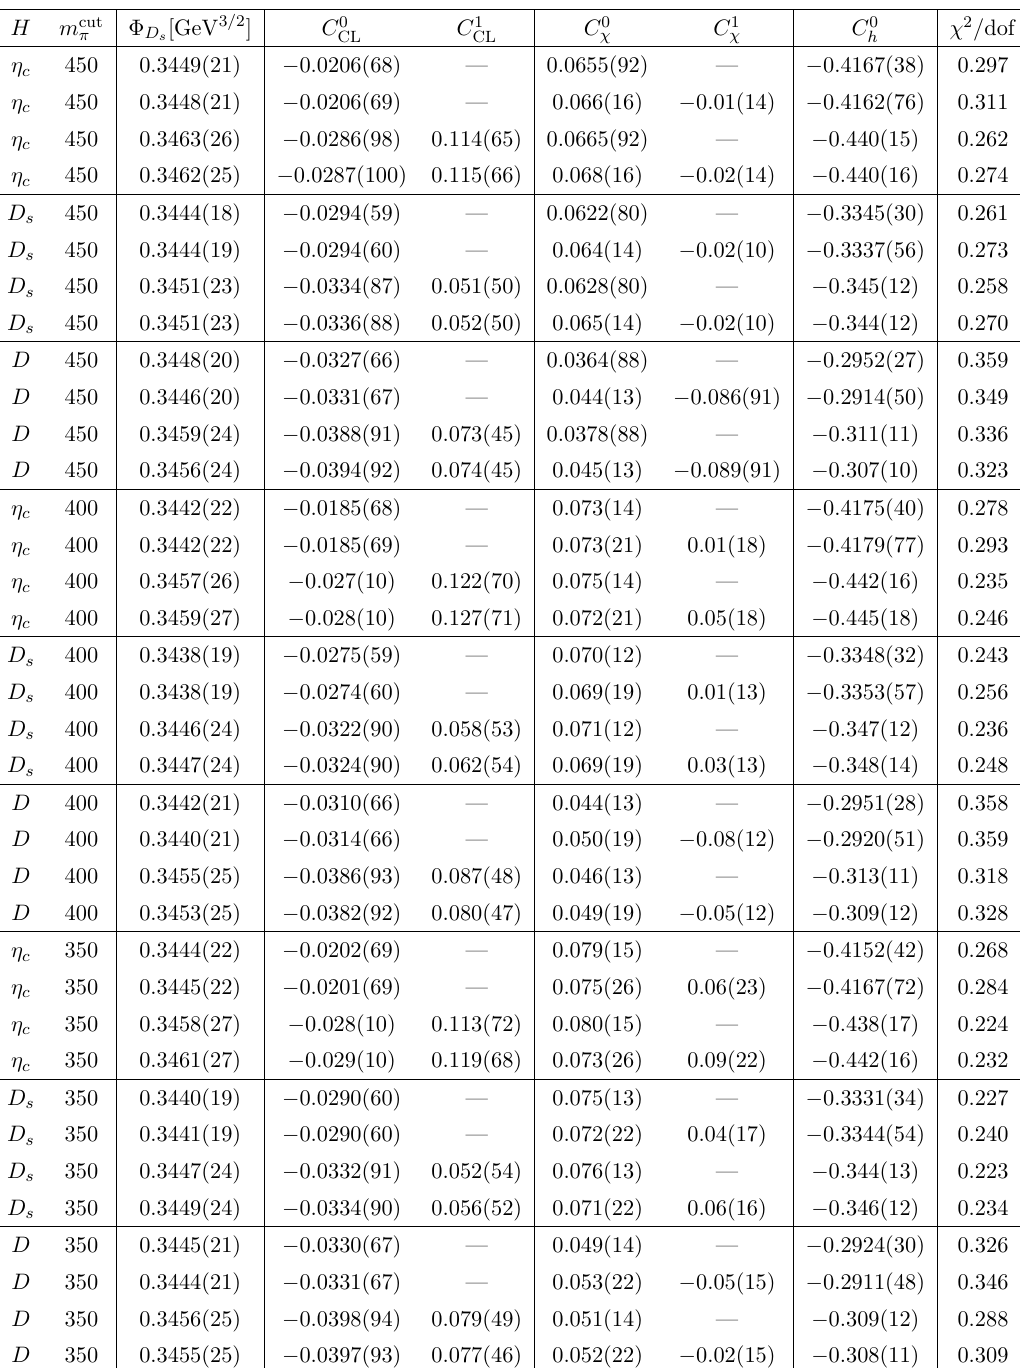
Table 16 . Fit results of the di(cid:11)erent versions of the global (cid:12)t ansatz (3.6) for the observable (cid:8) D